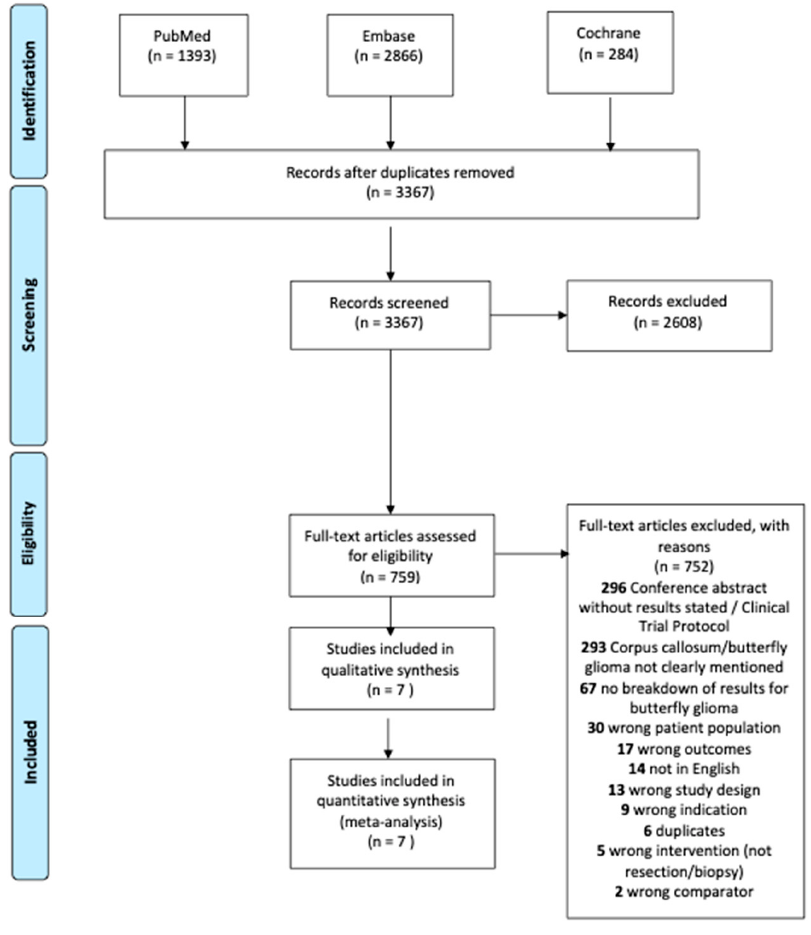
Figure 1. PRISMA flow diagram of included articles. Table 1. Study characteristics of included